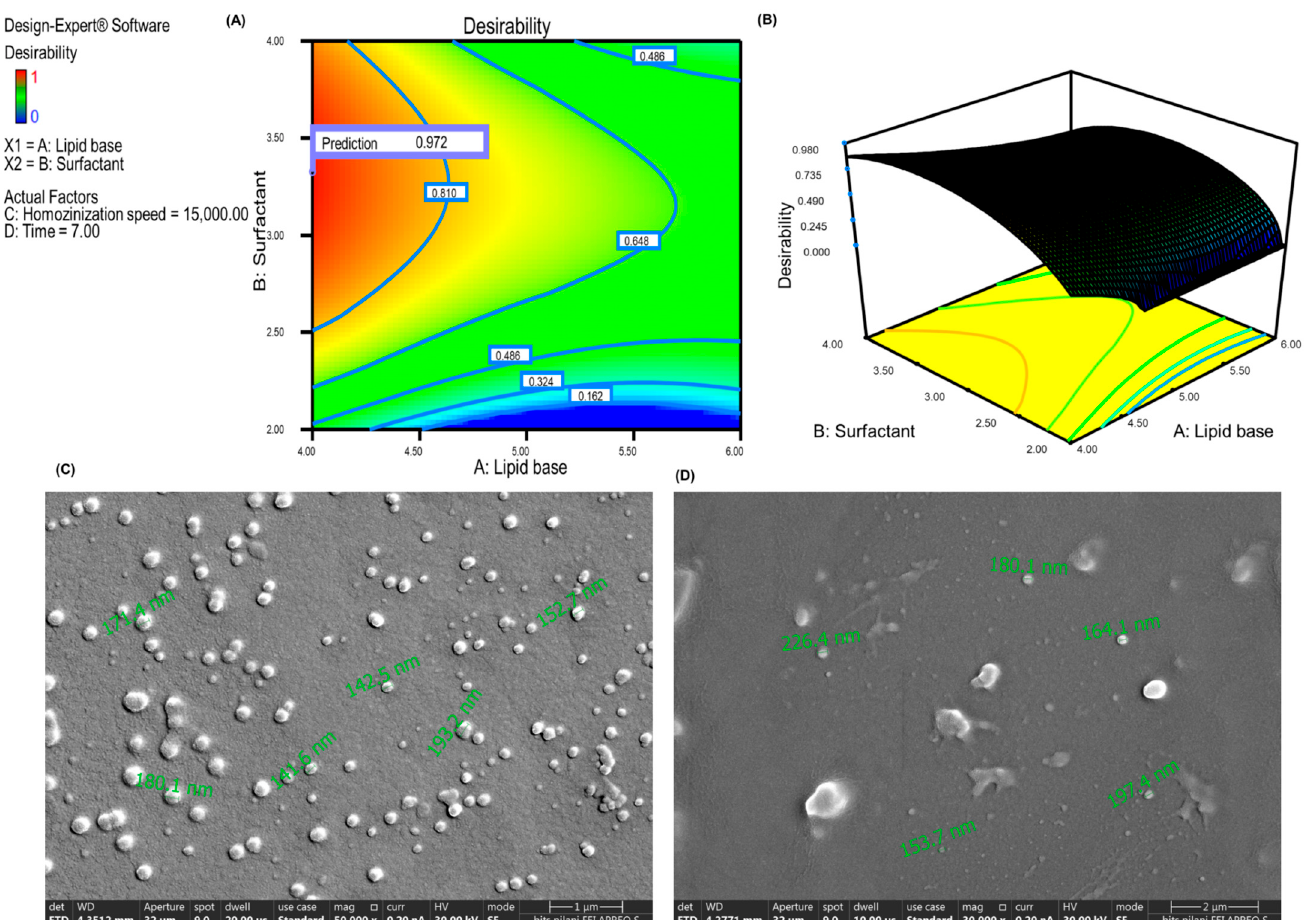
Figure 6. CCD desirability graphs illustrating factors against desirability value. ( A ) The contour plot graph. ( B ) The three-dimensional graph. ( C ) Morphological characterization FESEM image of CF018 emulsion. ( D ) The FESEM image of CF018 emulgel .